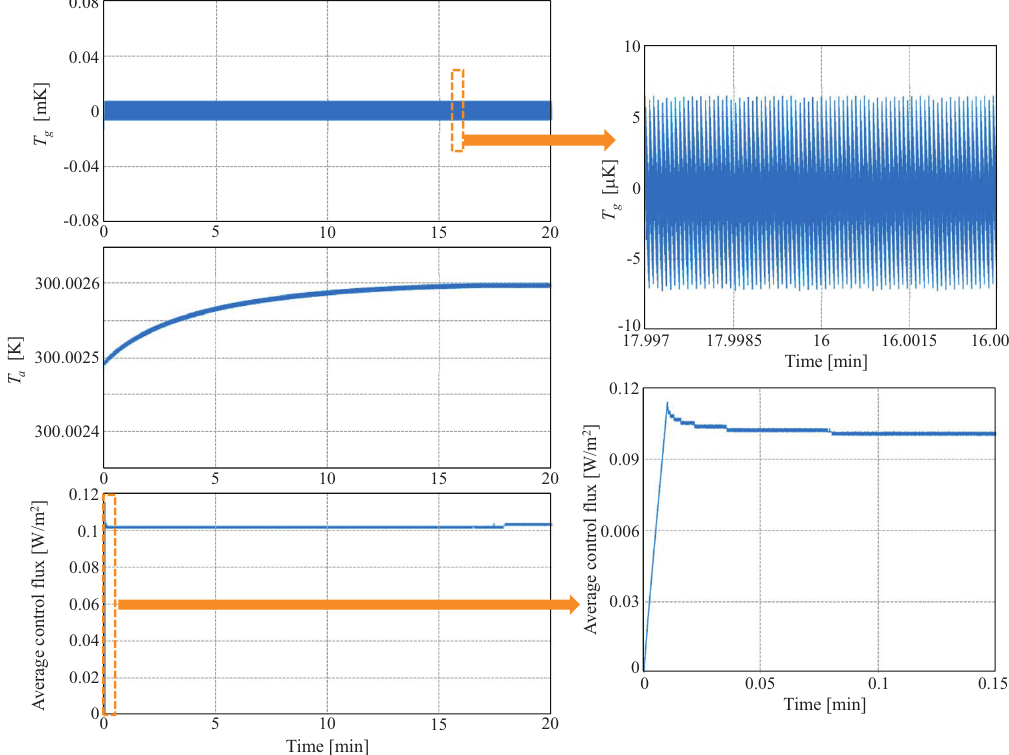
Figure 7. Control simulation results. At t = 0 the thermopile contacts the surface of the solid. Evolution of T g ( top ), T a ( mid ) and the average heat flux injected by the control in the thermopile ( bottom ), when the initial temperature of the thermopile is set slightly above that of the solid surface. The average heat flux is calculated as α p T ( L 1 , t ) J ( t ) , where J ( t ) is the average current injected by the control. Zoom views of T g in steady-state and of the average heat flux during the initial transient are